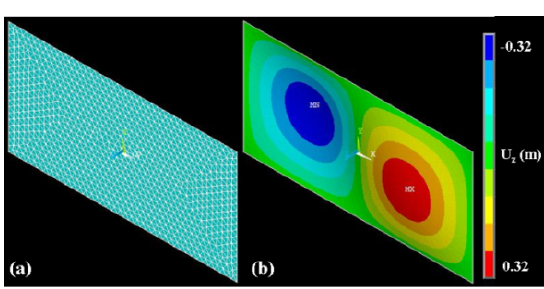
Figure 2. Non-perforated plate: (a) finite elements mesh; (b) First buckling mode shape.